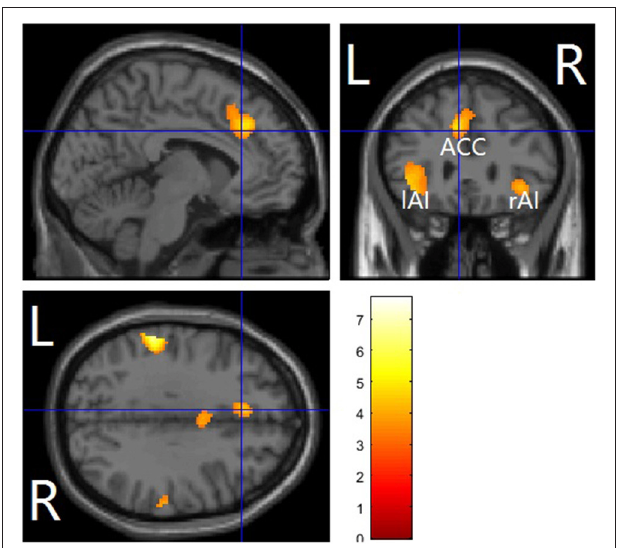
FIGURE 3 | Alcohol vs. placebo across pain and nopain conditions in a whole-brain analysis. The affective pain matrix was displayed. Voxel-wised